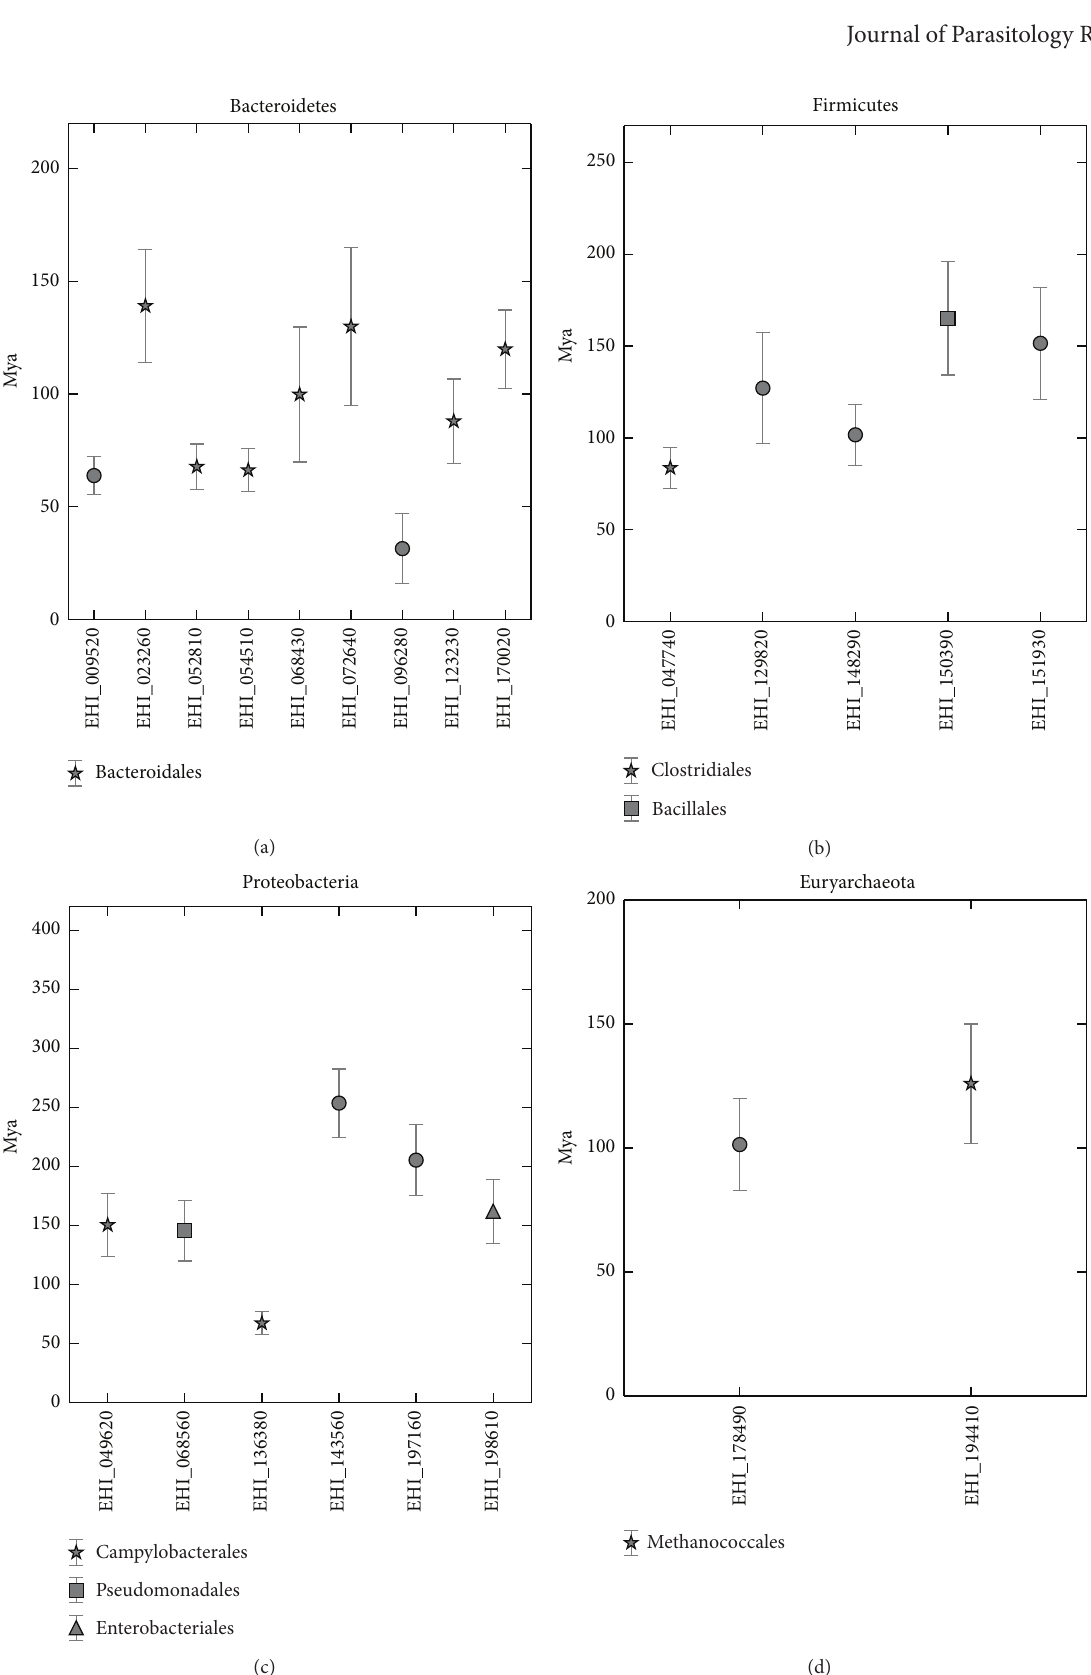
Figure 2: Times of horizontal gene transfer by phylogenetic groups. Measures of dispersion by standard deviation. Some simultaneous events specifically in group of Bacteroidales can be